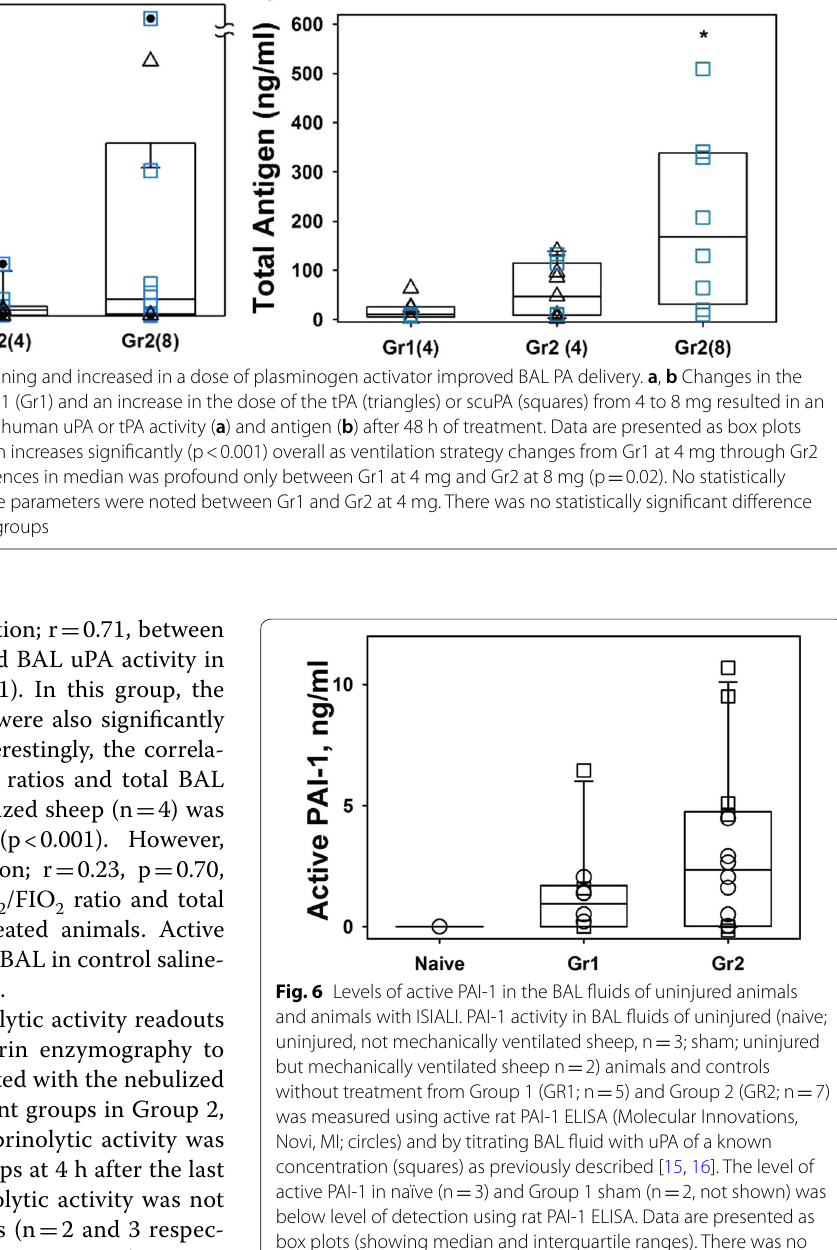
Fig. 6 Levels of active PAI-1 in the BAL fluids of uninjured animals and animals with ISIALI. PAI-1 activity in BAL fluids of uninjured (naive; uninjured, not mechanically ventilated sheep, n 3; sham; uninjured = but mechanically ventilated sheep n 2) animals and controls = without treatment from Group 1 (GR1; n 5) and Group 2 (GR2; n 7) = = was measured using active rat PAI-1 ELISA (Molecular Innovations, Novi, MI; circles) and by titrating BAL fluid with uPA of a known concentration (squares) as previously described [15, 16]. The level of active PAI-1 in naïve (n 3) and Group 1 sham (n 2, not shown) was = = below level of detection using rat PAI-1 ELISA. Data are presented as box plots (showing median and interquartile ranges). There was no statistically significant difference between levels of active PAI-1 in the Group 1 versus 2 animals versus controls, although a trend towards increased BAL PAI-1 activity in sheep with ISIALI was